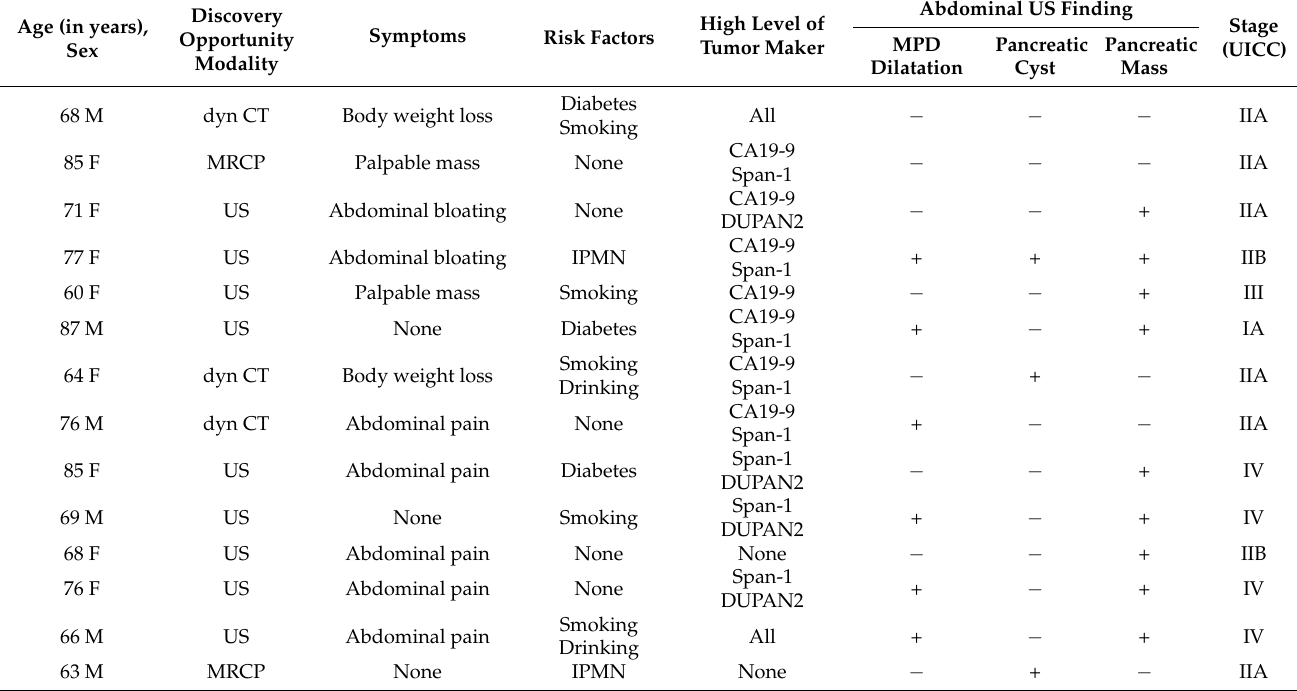
Table 2. Characteristics, risk factors, imaging findings, and disease stages of patients with pancreatic cancer ( n =